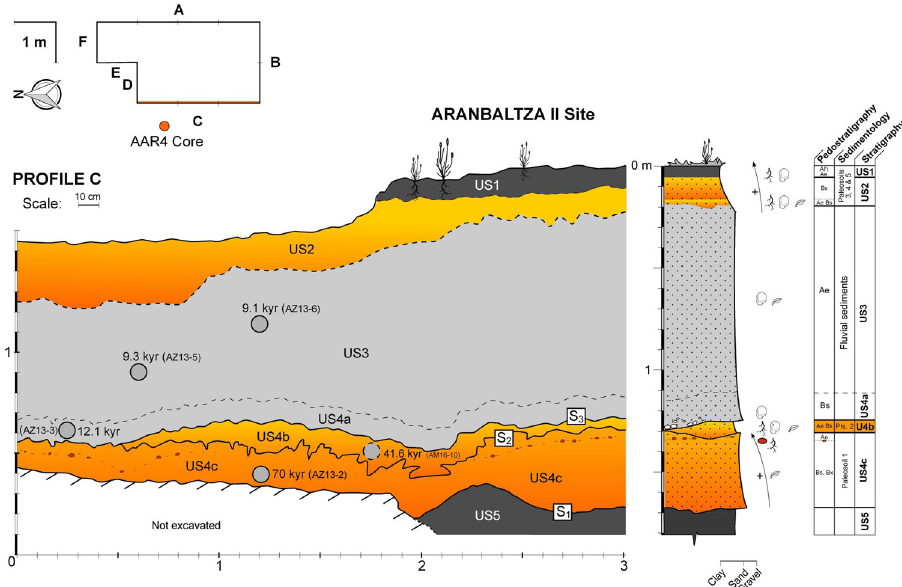
Fig 4. Stratigraphic section between Area 1 and 3 (section C) and synthetic stratigraphic section with the position of the dated OSL samples Stratigraphy. A detail photograph of the sequence in corner C/D is presented in S6 Fig in S1